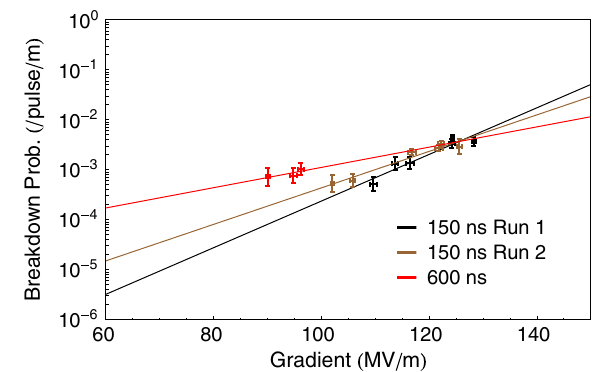
FIG. 18. Breakdown probability per pulse per meter of struc- ture vs gradient for PBG-E at pulse lengths of 150 and 600 ns.